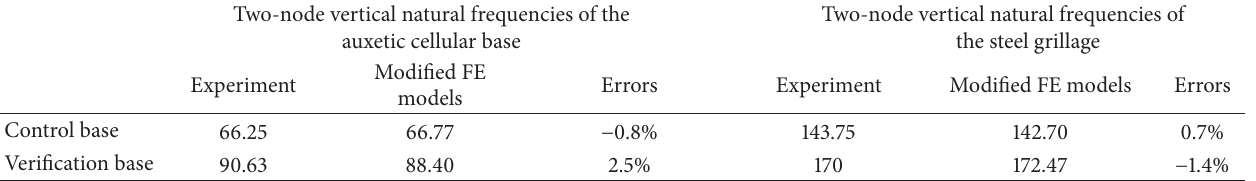
Table 4: Comparison of results between the experiment and modified FE models (Hz).